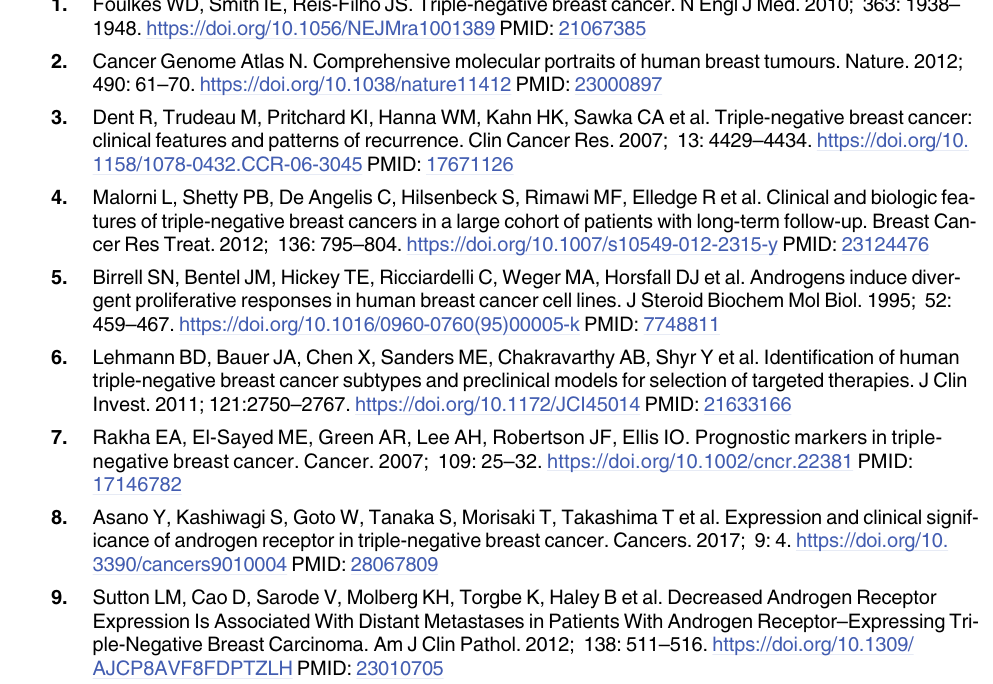
S2 Table. SUV according to androgen receptor status with varying cutoff values for max androgen receptor positivity. AR: androgen receptor. S3 Table. Univariate and multivariate analyses for determining SUV AR positivity. AR: androgen